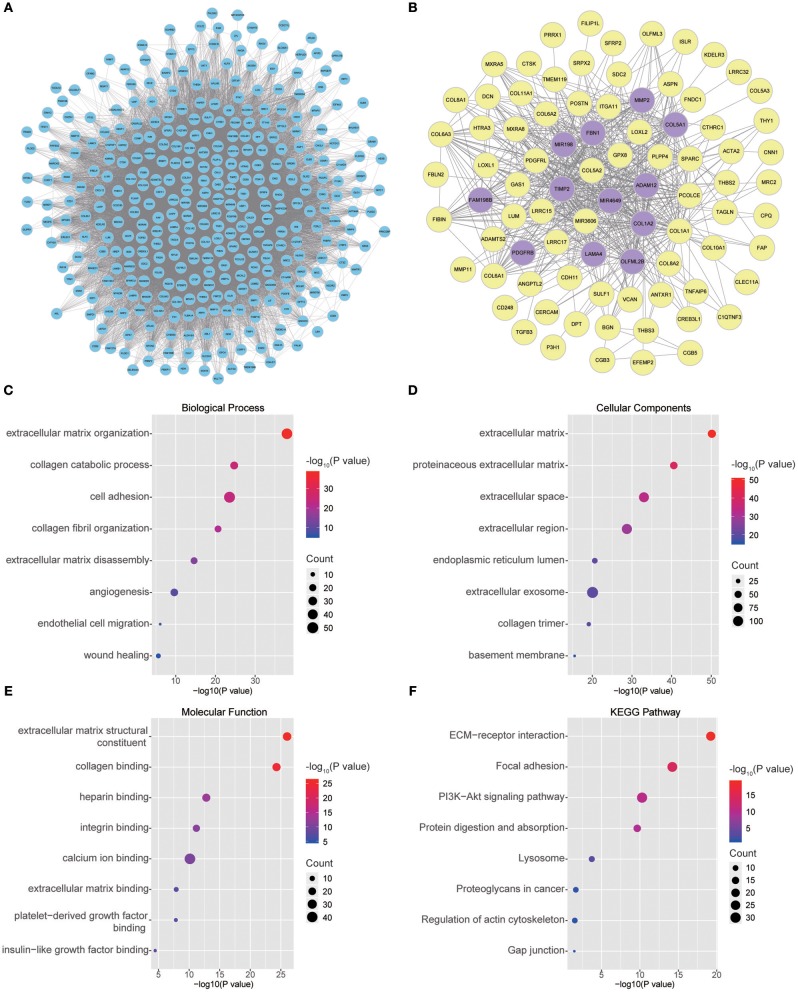
(A) Visual representation of the coexpression networks in the key module. (B) Coexpression networks when only a weight of more than 0.2, as calculated by WGCNA, was considered. The hub genes are highlighted. (C–F) GO and pathway enrichment analysis of brown module genes. (C) BP analysis. (D) CC analysis. (E) MF analysis. (F) KEGG pathway analysis.